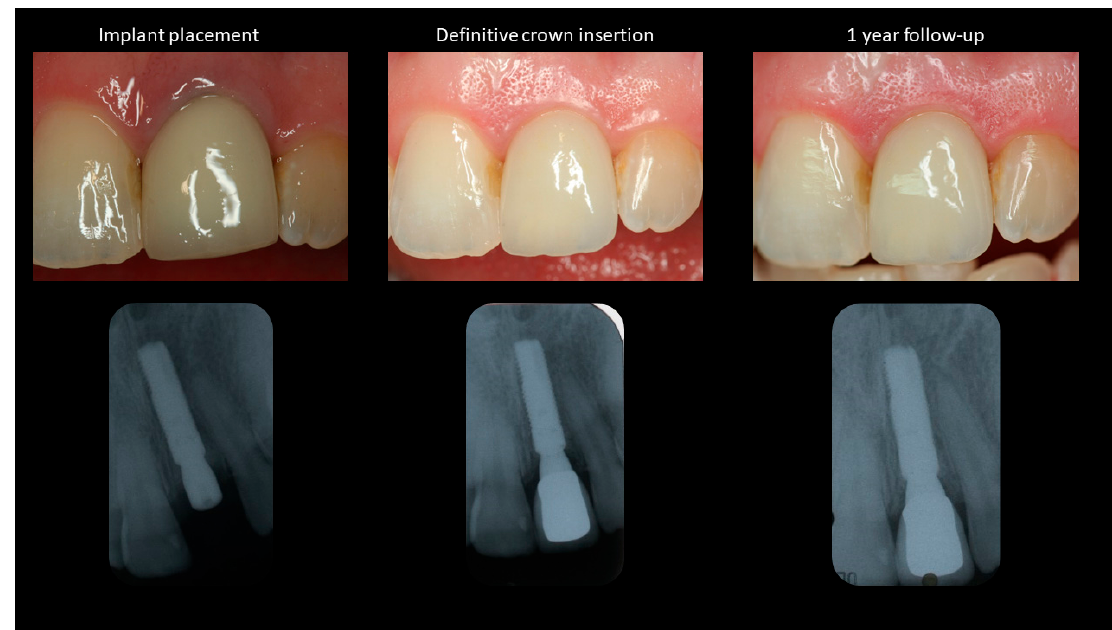
Figure 2. Peri ‐ implant soft and hard tissue levels at implant placement, crown insertion and 1 ‐ year follow ‐ up.